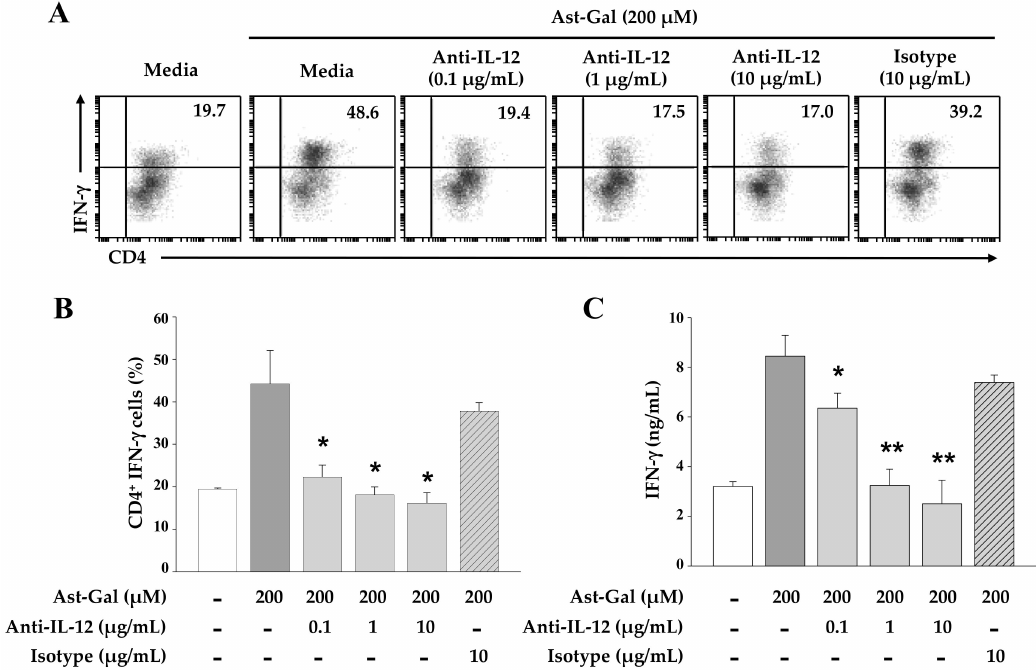
Figure 5. Ast-Gal-treated DCs upregulate IFN- γ production in CD4 + T cells in vivo. The iDCs (1 × 10 6 cells/well) were pulsed with 10 µ g/mL of OVA for 2 h. Next, the cells were stimulated for 6 h with Ast-Gal (100 µ M) or media alone (control), harvested, and then used to immunize OT-II mice via footpad injection on Day 1 at a total of 1 × 10 6 DCs per mouse. On Day 7, the lymph node cells were collected and incubated for 3 days in the presence of OVA 100 µ g/mL. ( A ) The percentages of IFN- γ -, IL-4-, and IL-17-expressing T cell populations were determined by flow cytometric analysis. ( B ) The results from ( A ) are summarized as mean ± SD ( n = 3). * p < 0.05 compared with media-treated DCs. ( C ) Cell culture supernatants were harvested, and the IFN- γ , IL-4, and IL-17 levels were detected by a sandwich ELISA. The data are expressed as mean ± SD from three independent experiments. * p < 0.05 compared with media-treated